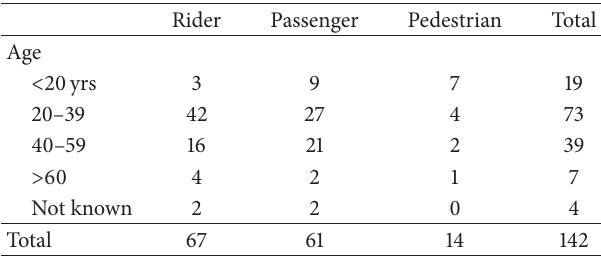
Table 1: Cross tabulation of status by age group.